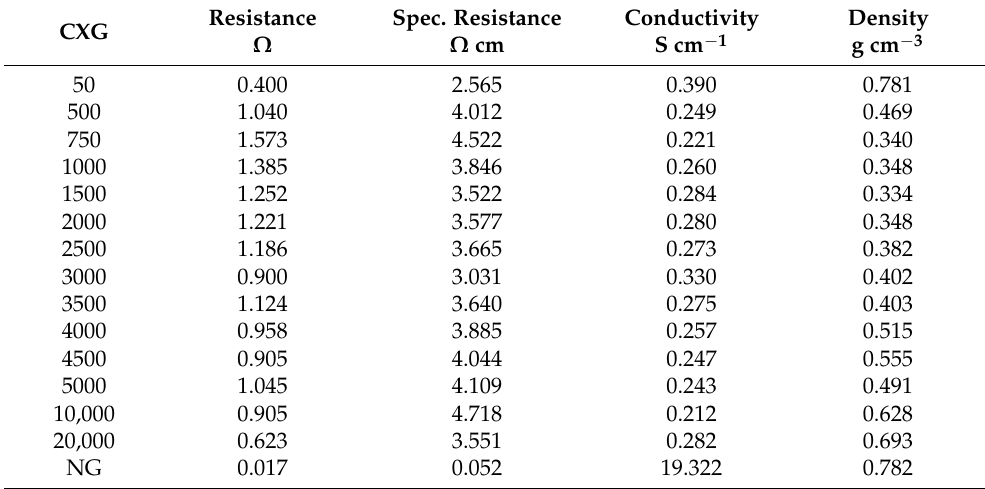
Table A1. Electronic conductivity values of carbon xerogels and natural graphite.